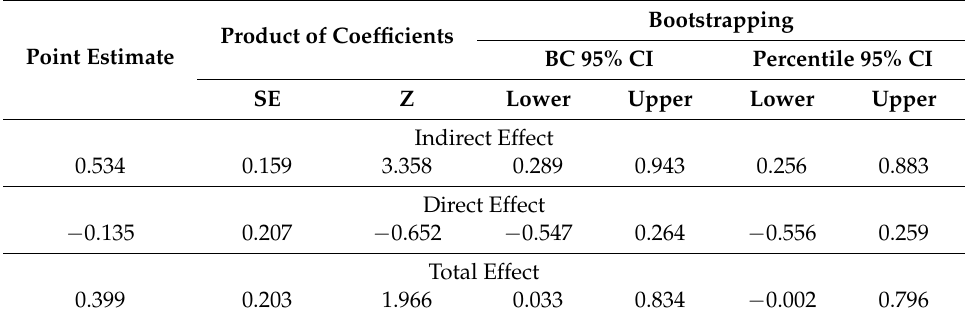
Table 12. Test table of the mediation effect between AOC and